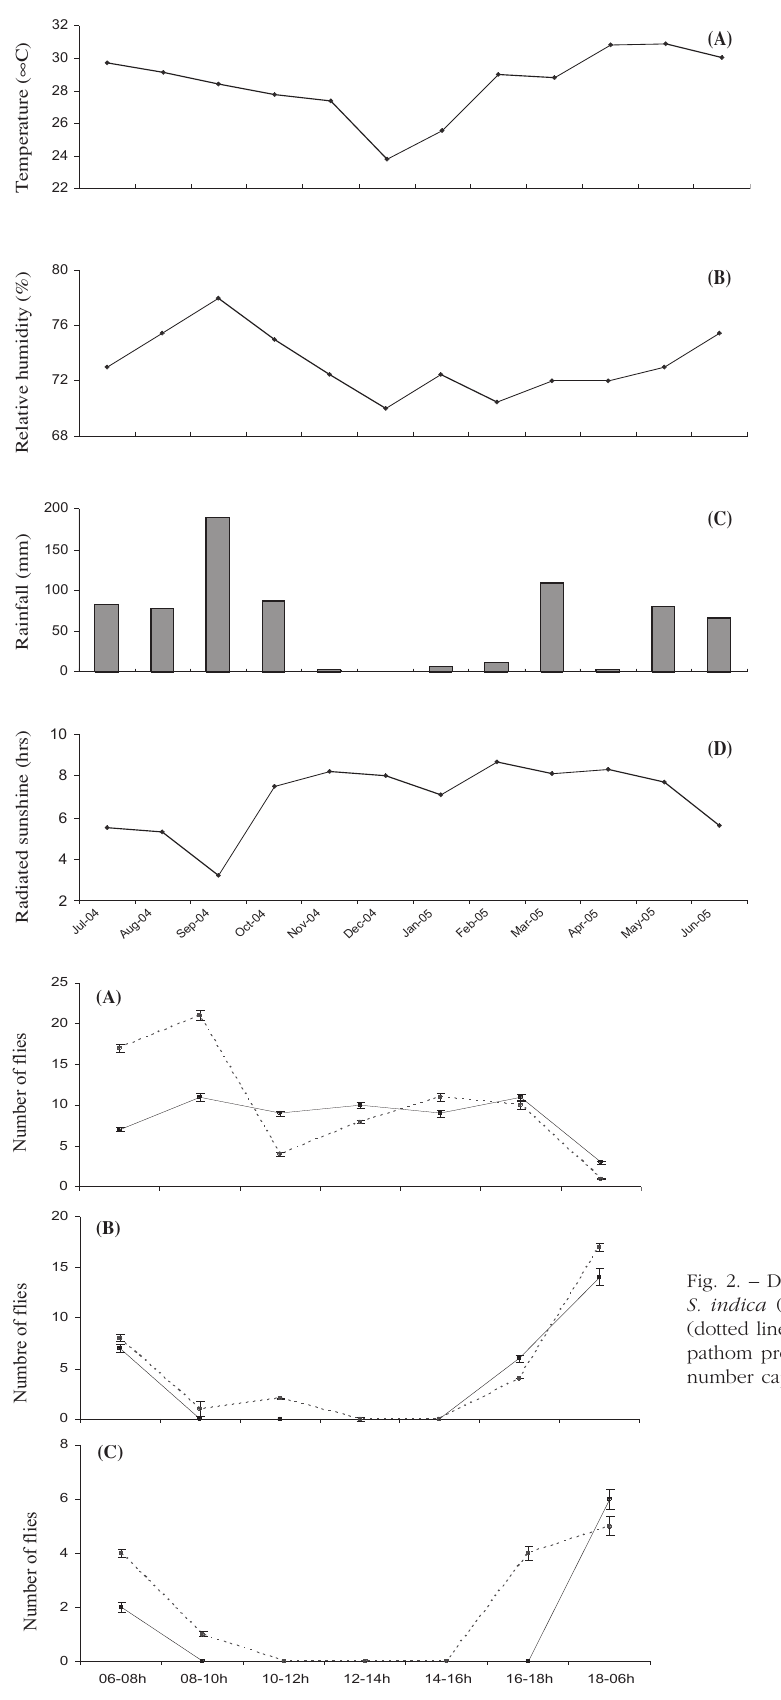
Fig. 1. – Monthly mean ambient temperature (A), relative humidity (B), rainfall (C) and radiated sunshine (D). Data obtained from Kamphaengsaen Meteorological Station.